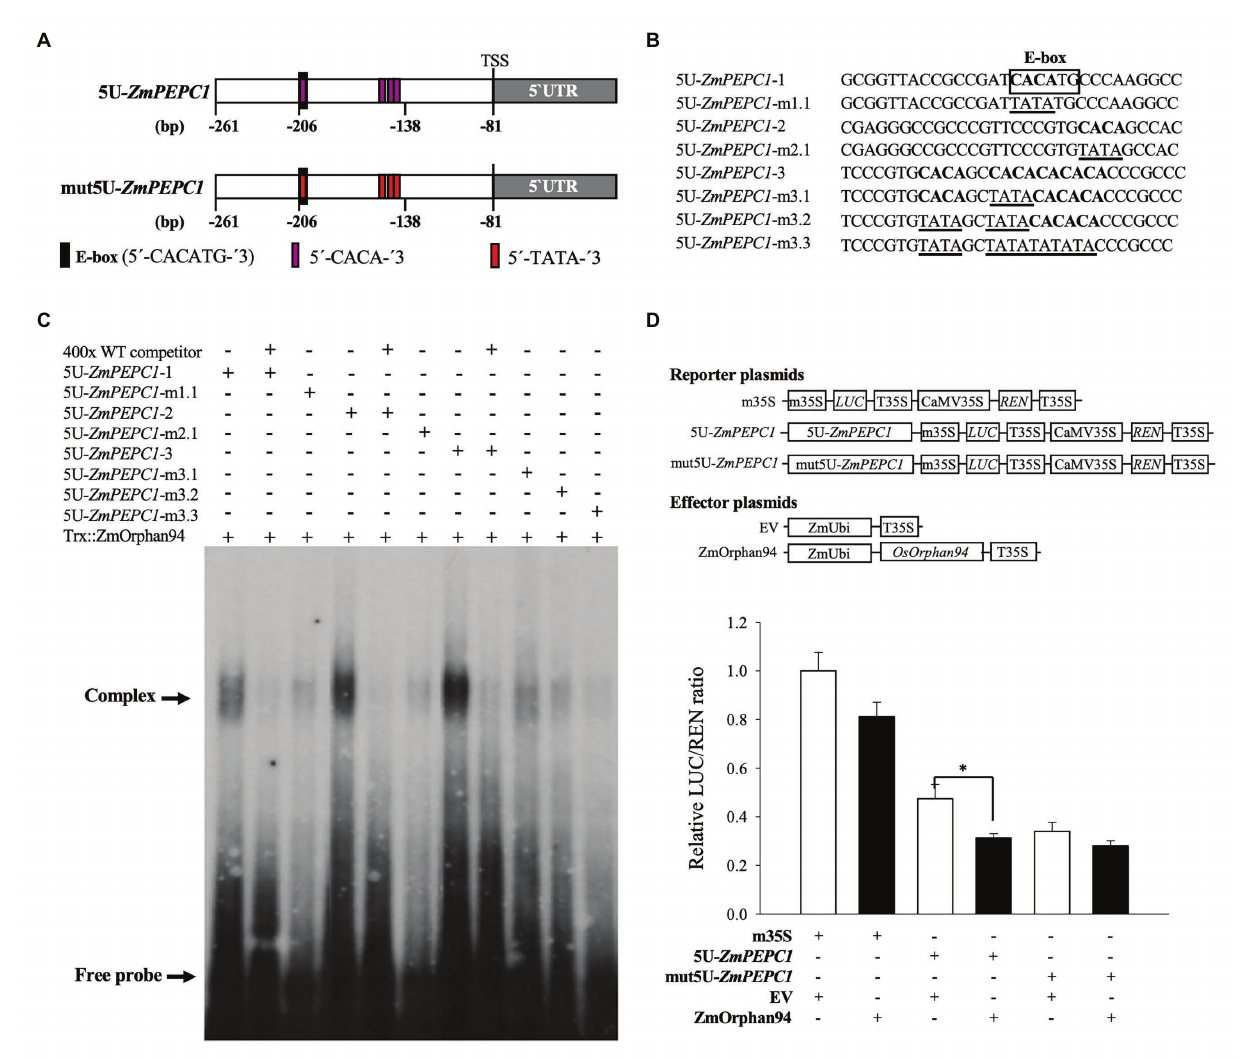
FIGURE 5 | Analysis of the interactions between ZmOrphan94 and the cis -elements present in the 5 U ZmPEPC1 fragment. (A) Schematic representation of the 5 U fragment (within ZmPEPC1 upstream region) indicating the relative positions of the E-box (ZmbHLH90 binding site; black rectangle) and 5 ' -CACA-3 ' (ZmOrphan94 binding site; magenta rectangle) sequences, as well as its mutated form (mut5U- ZmPEPC1 ). mut5U- ZmPEPC1 fragment has the ZmOrphan94 binding sites mutated from 5 ' -CACA-3 ' to 5 ' -TATA-3 ' . Nucleotide numbers refer to the ZmPEPC1 translational start codon ATG (+1). (B) Nucleotide sequences of DNA probes used in electromobility shift assays (EMSA). Putative ZmOrphan94 binding sites (5 ' -CACA-3 ' ) are represented in bold. The CACA sequences mutated to TATA are underlined. The binding site for ZmbHLH90 (E-box) is indicated. (C) EMSA of the Trx::ZmOrphan94 with probes derived from the 5 U ZmPEPC1 upstream region. The “+” and “ − ” indicate presence and absence of respective protein or probe. The “400x” indicates a 400-time excess of unlabeled wild-type (WT) probe. (D) Trans-activation assay to analyze the function of the ZmOrphan94 binding sites in the 5 U- ZmPEPC1 fragment. Data represent means ± SEM ( n = 10–12). Differences are statistically significant ( t -test, * p <